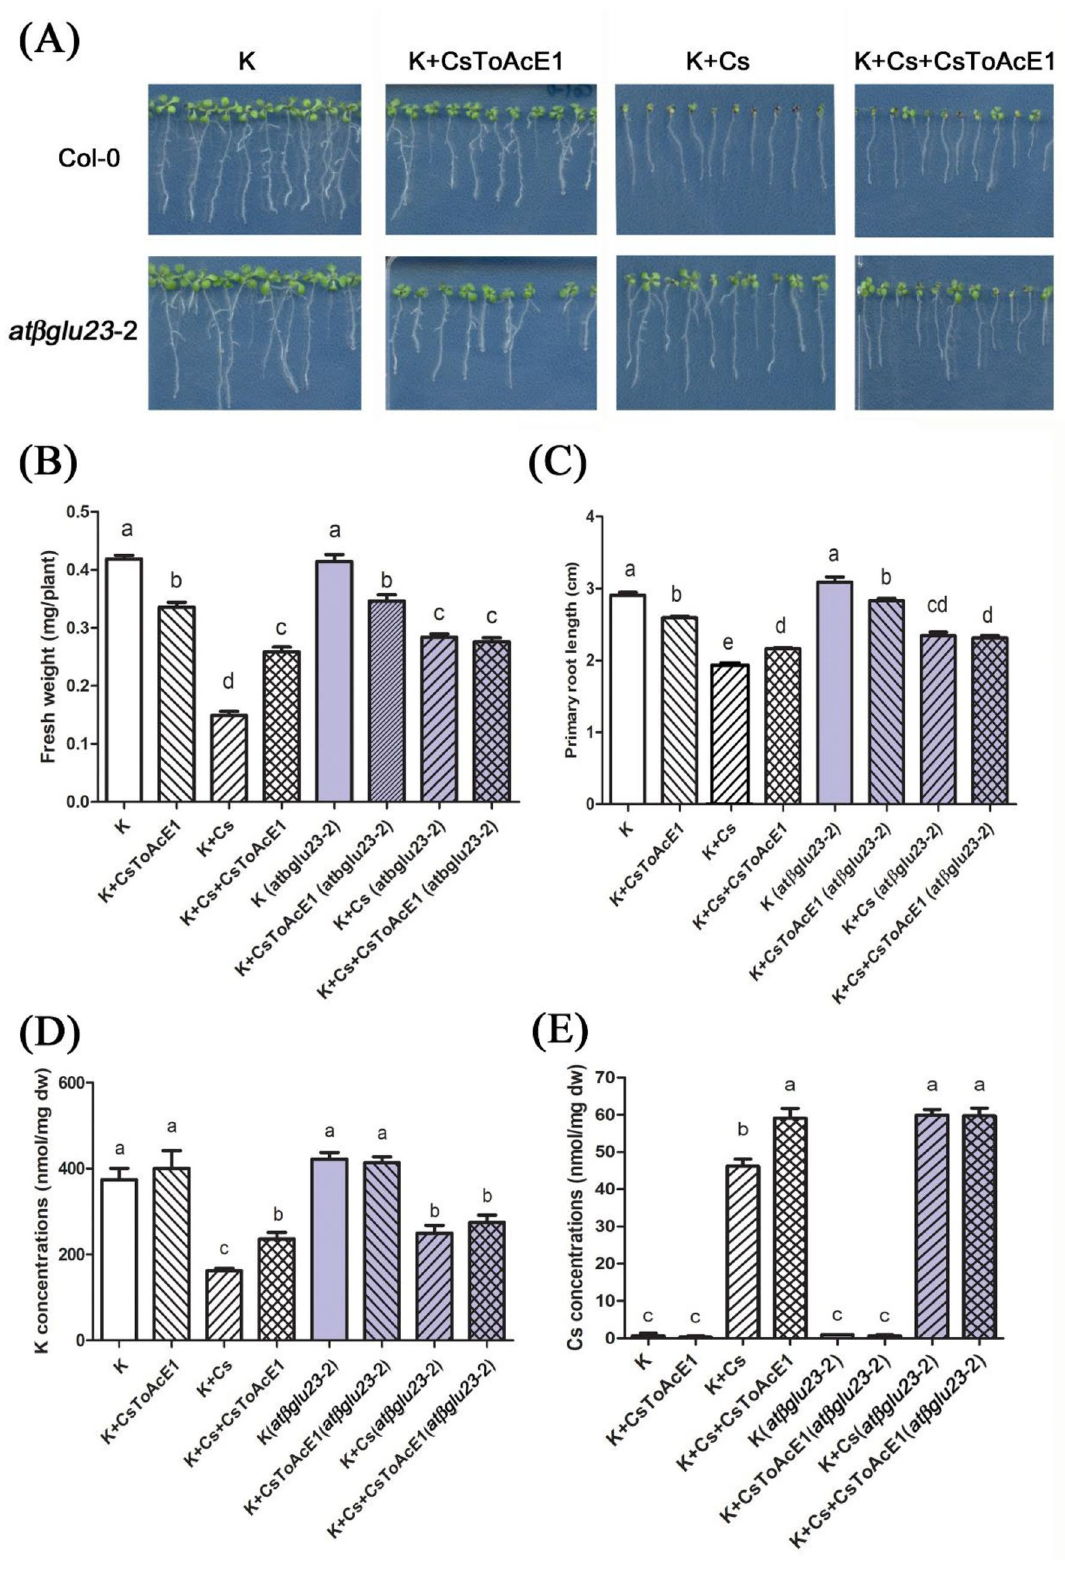
Figure 3. Effect of CsToAcE1 on Cs stressed wild-type (Col-0) and atβglu23 mutant Arabidopsis plants. ( A ) Response of wild-type and atβglu23- 2 mutant Arabidopsis plants to CsToAcE1 under Cs-stress (K plus Cs plus CsToAcE1) and non-stress (K plus CsToAcE1) conditions. Plants were grown for 8 days on agar media containing 0.5 mM KCl as a control (K) and media containing 0.3 mM CsCl (+ Cs) with or without the addition of 25 µM CsToAcE1 (+ CsToAcE1). The fresh weight of aerial parts ( B ) and primary root lengths ( C ) were analyzed (n > 60). Elemental analysis of K ( D ) and Cs ( E ) concentrations in planta . K and Cs levels were quantified using a NexION 300 ICP-MS System. Data represent the mean ± SE (n = 3). Different letters indicate significant differences ( p < 0.05) between treatments determined by a one-way ANOVA followed by a Bonferroni’s multiple comparisons